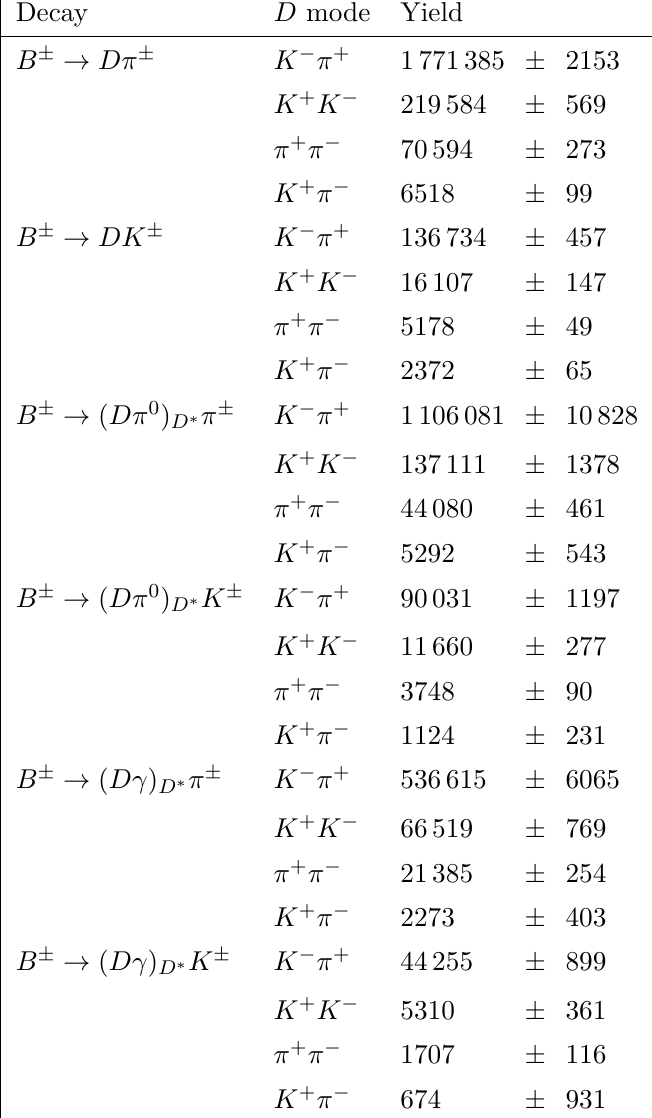
Table 3 . Yields for the 24 signal